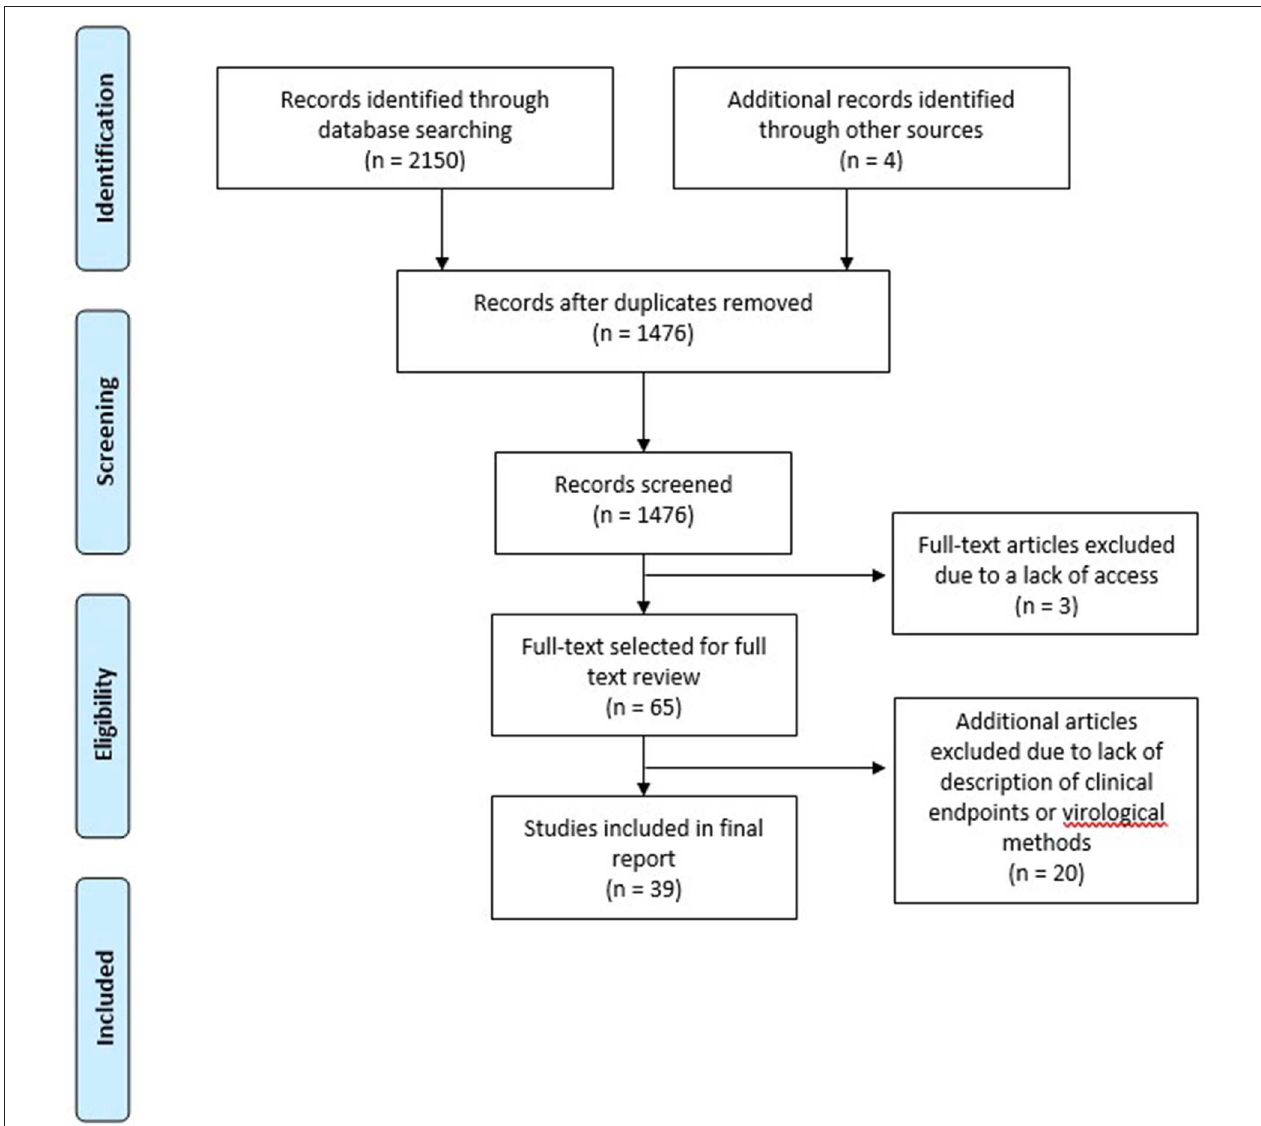
FIGURE 1 | PRISMA flow diagram of the literature search